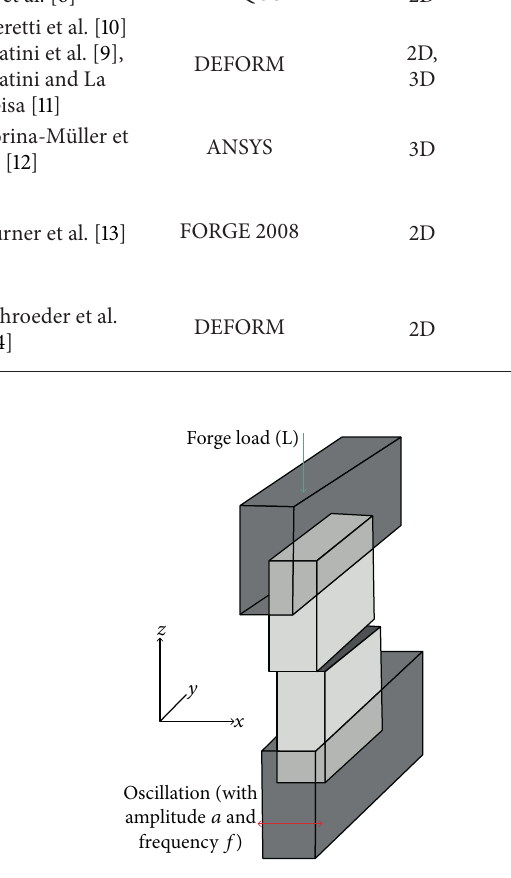
Figure 1: Schematic of a linear friction weld, showing the testpieces, tooling, and axes of